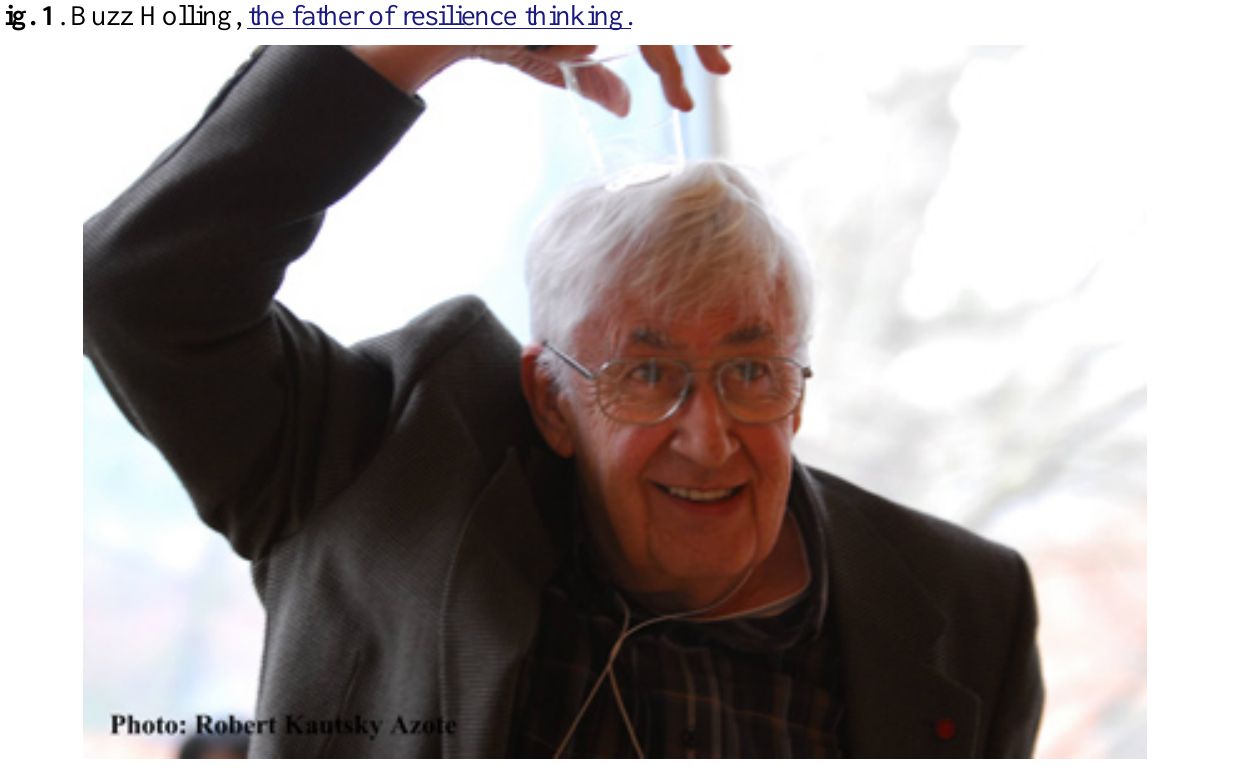
Fig. 1 . Buzz Holling, the father of resilience